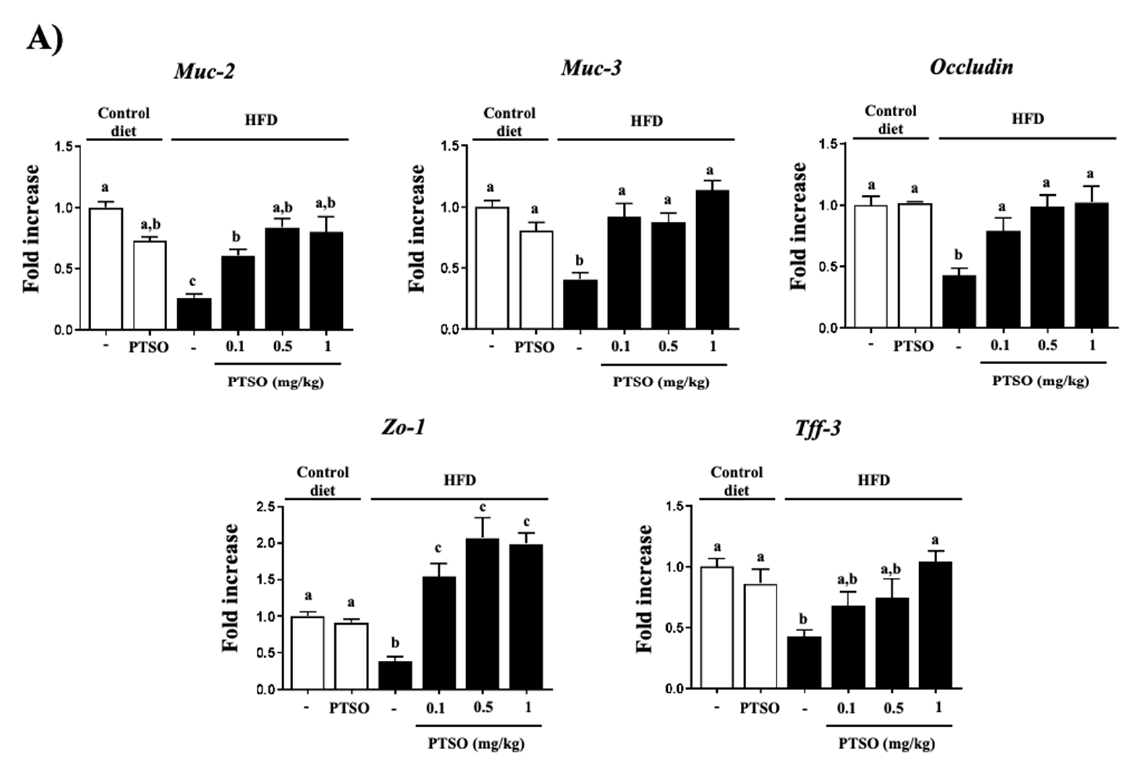
Figure 5. Effects of propyl propane thiosulfonate (PTSO) administration on the liver and fat: ( A ) gene expression of Ampk , Glut4 and Tlr4 , which was analyzed using real-time qPCR and LPS plasma concentrations; ( B ) infiltration and composition of the immune population in control and high-fat diet (HFD)-fed mice. Groups with different letters statistically differed ( p < 0.05).